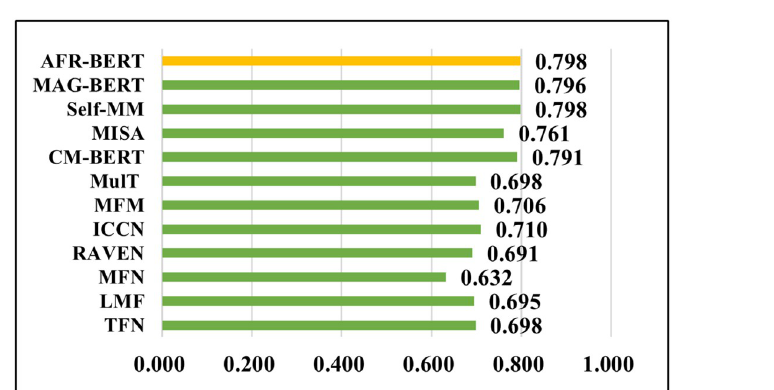
Table 5. Comparative experiments of multimodal sentiment analysis models on the dataset CMU-MOSEI. Model